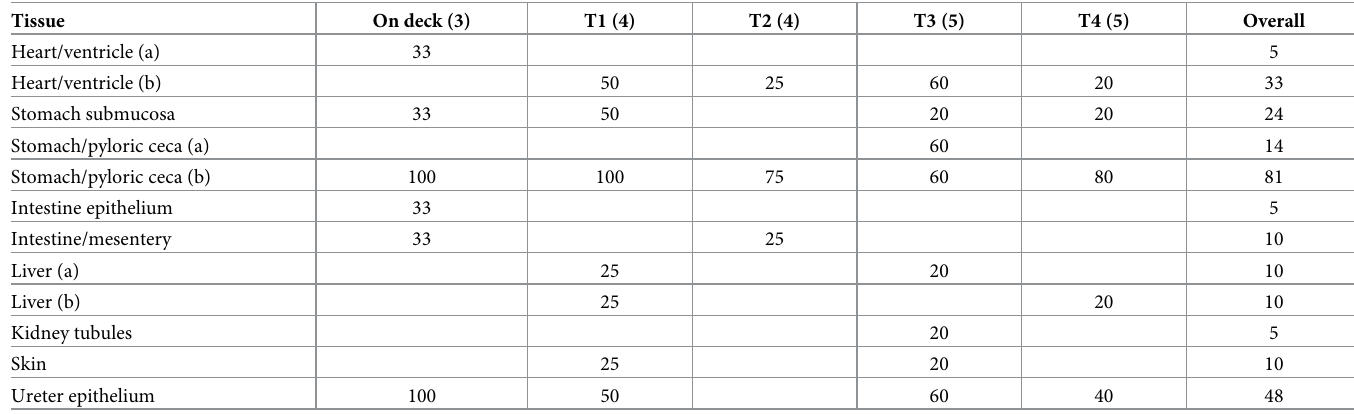
Table 2. The percent of histological findings in tissues of shortspine thornyhead by treatment type.